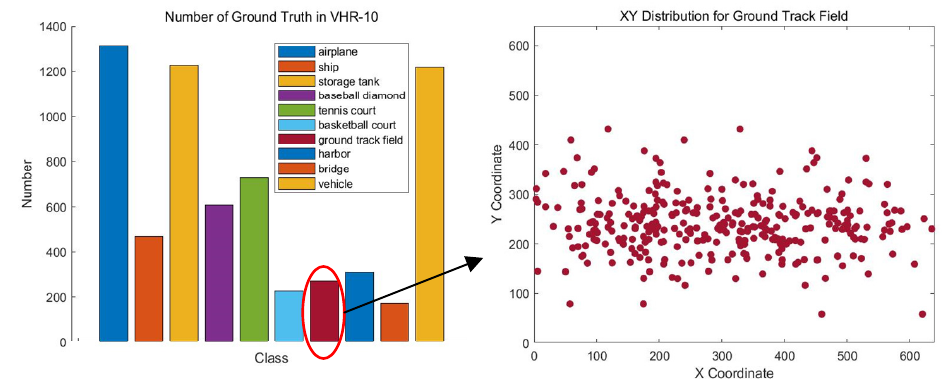
Figure 11. XY distribution for the Ground Track Field class of the NWPU VHR-10 dataset.